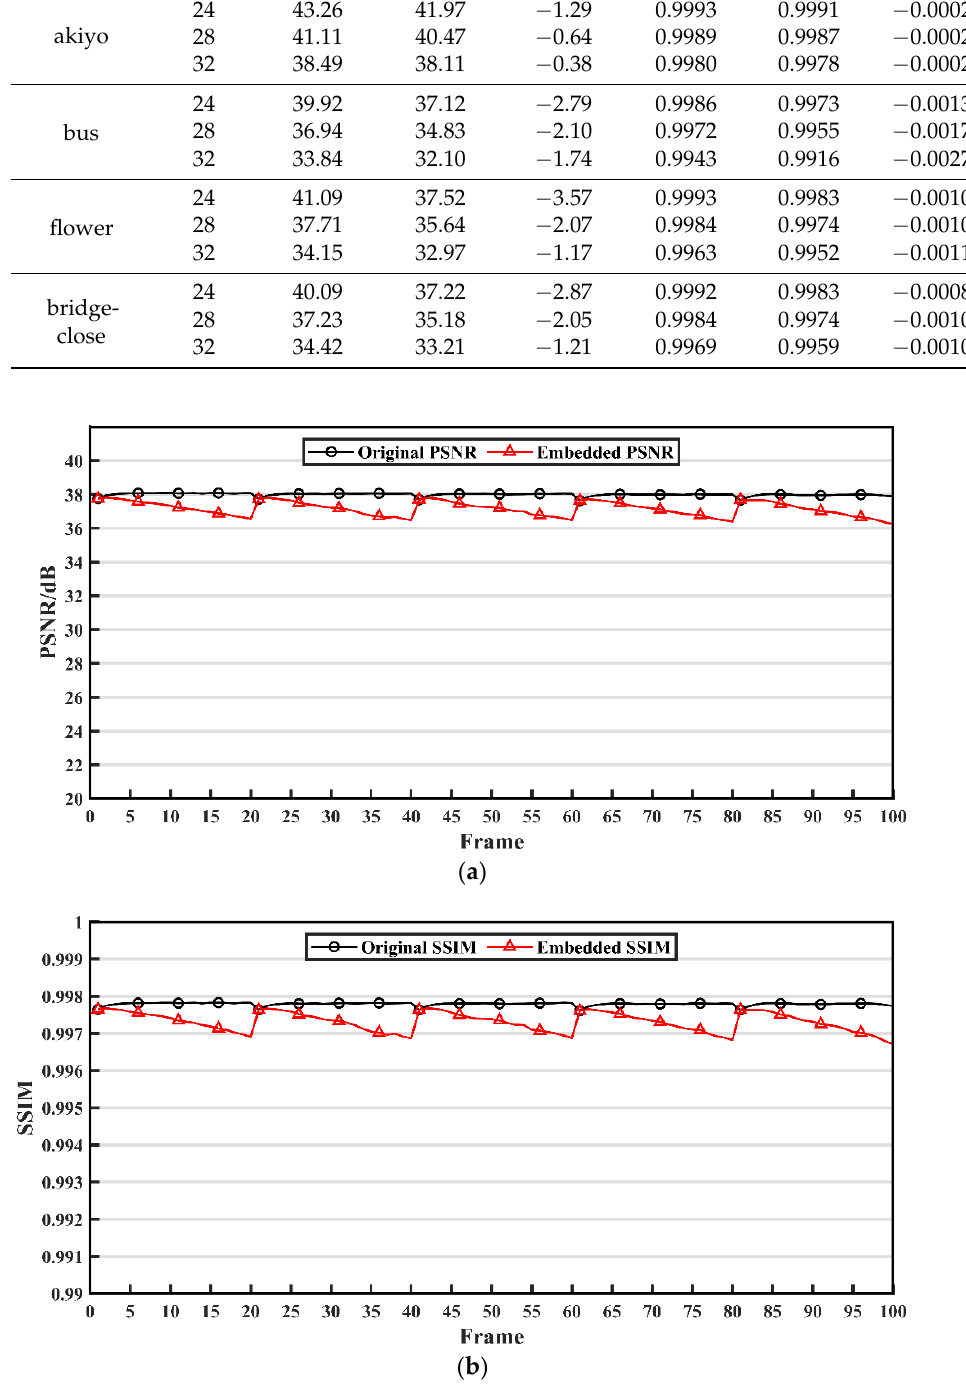
Figure 11. PSNR and SSIM before and after embedding. ( a ) PSNR before and after embedding, ( b ) SSIM before and after embedding.